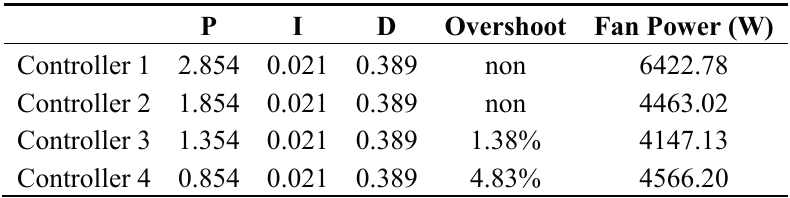
Table 1. Four PID controllers in various time domain specifications and the power consumption of Fans 3 and 4.